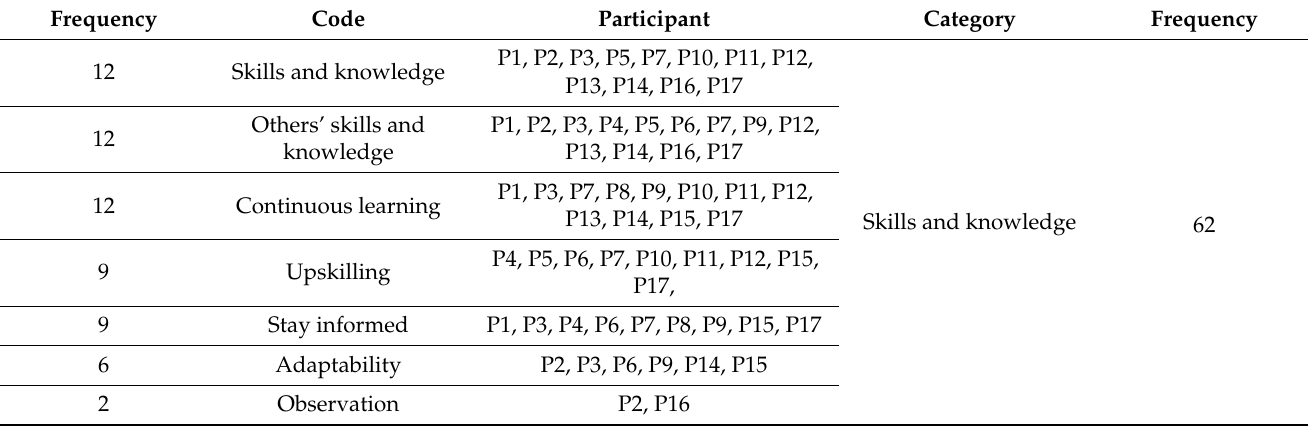
Table 2. Manageability Resources Used by